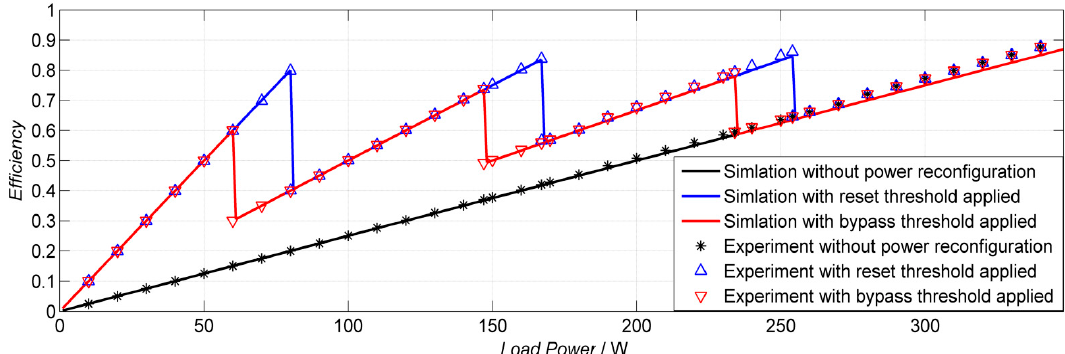
Figure 15. The simulation and experiment results of the efficiency in respect to the external load power (4 modules).